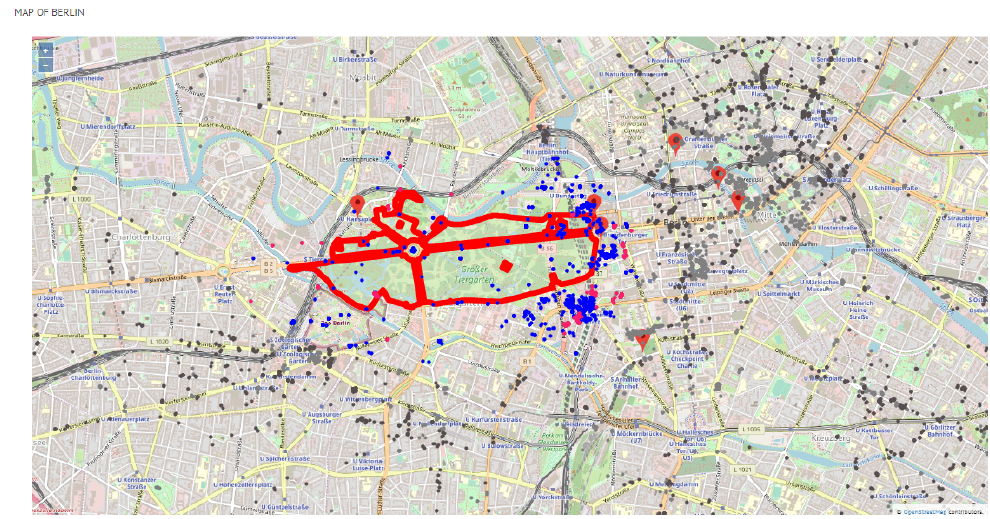
Figure 13. Zoom in on Großer Tiergarten (site 10).